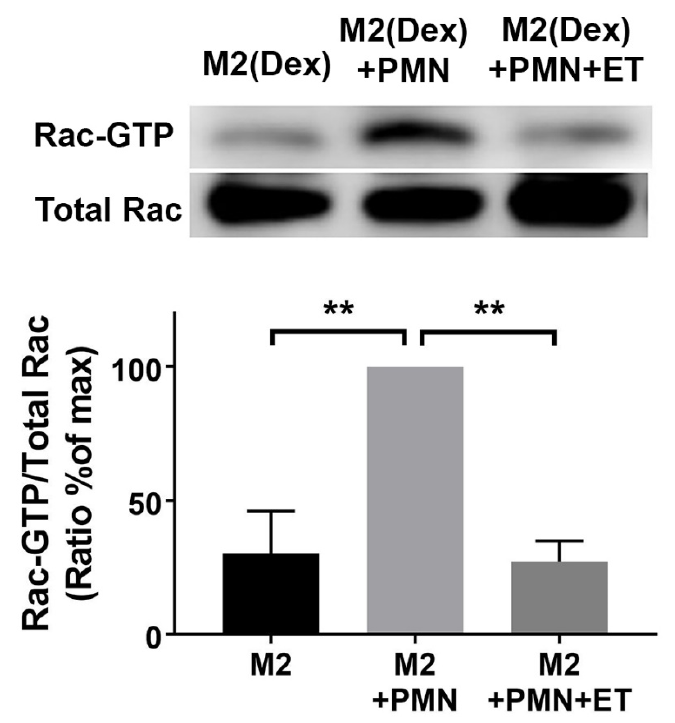
Figure 6. The inhibition of Rac activation by the Edema Toxin: The M2(Dex) macrophages (M2) were preincubated with or without 10 nM ET for 4 h and then incubated with human apoptotic PMNs that had been opsonized with Protein S for 15 min. The total Rac and Rac-GTP were measured from the lysates by a Western blot. Upper panel: The representative experiment shows the active and total Rac following ECL detection of the Western blot. Lower panel: The quantification of active Rac is expressed as the mean ± SEM of Rac-GTP/Total Rac ratios expressed as a percentage of the maximum. The data were analyzed by one-way ANOVA with Dunnet’s multiple comparison posttest (** p < 0.01). Treatment with ET inhibited the Rac activation in the presence of Protein S-opsonized apoptotic PMN. The data include results from four independent donors.